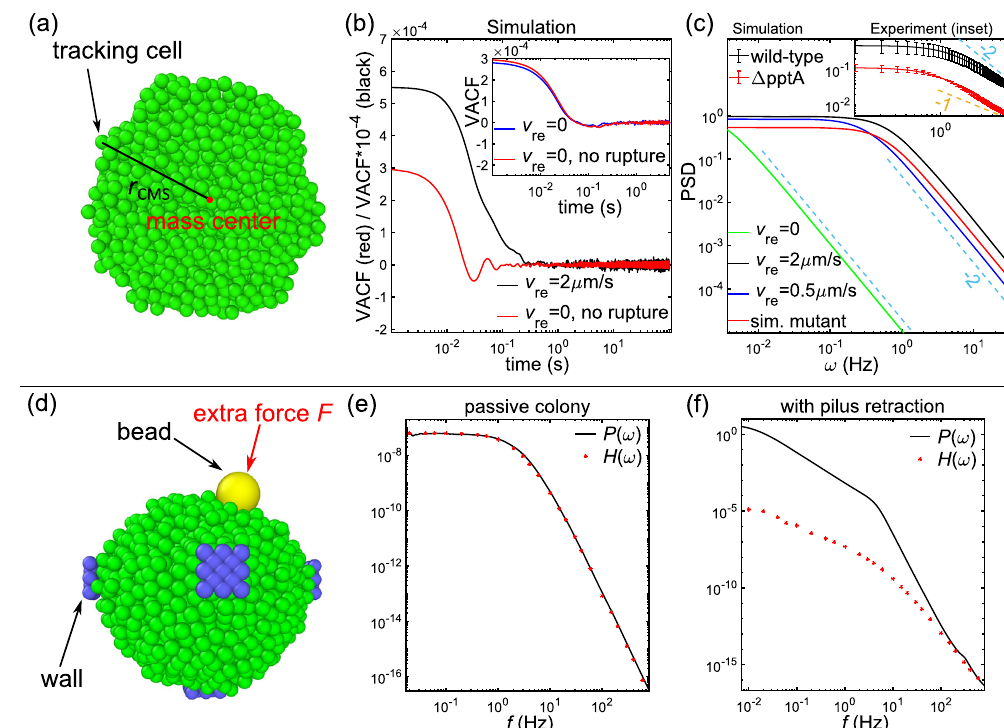
Fig. 5 Active fl uctuations at the periphery of colonies. a Simulated setup for quantifying boundary fl uctuations by measuring the radial distance r CMS between a fi xed angular position on the surface and the colony center. b Active pilus retraction results in a slower decay of the velocity autocorrelation function (VACF) of the surface point. Main plot: colonies are fi rst grown from cells with retracting pili and the role of pili is studied after growth is switched off. Inset: colonies are grown with retraction-de fi cient cells. c Active pilus retraction produces a power spectral density of fl uctuations characteristic for a visco-elastic material with an elastic behavior at low frequencies. For passive colonies, v re ¼ 0, bond rupture results in a viscous material behavior. Colony ¼ 50s (cid:2) 1 , size is 4000 cells. For comparison with experimental data, a small colony with 600 mutant cells is simulated having a higher binding rate k mutant bind ¼ 1s (cid:2) 1 and lower retraction velocity v ¼ 0 : 5 μ m = s. Inset: experimental data for wild-type cells and a Δ pptA strain, error bars lower rupture rate k mutant re rupt show standard deviations with three samples. d Simulated setup for colony-shape perturbation. e Simulated mutant colonies with retraction-de fi cient pili that form permanent bonds. The equilibrium fl uctuation-response relationship holds. f For simulated wild-type cells, the equilibrium fl uctuation-response relationship is strongly violated ( v re ¼ 1 : 0 μ m = s, d bind = 3.0 μ